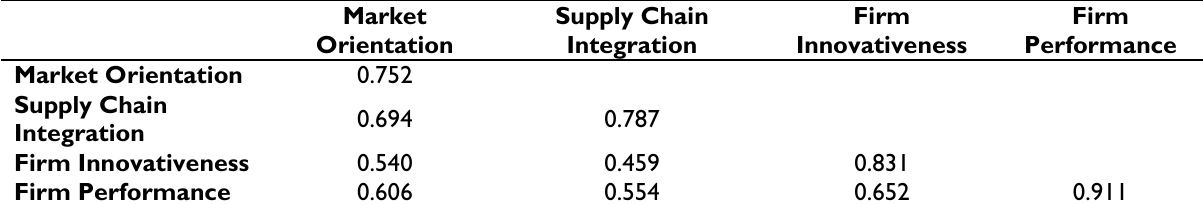
Tabel 3. Discriminant Validity Test Result (Fornell-Larcker